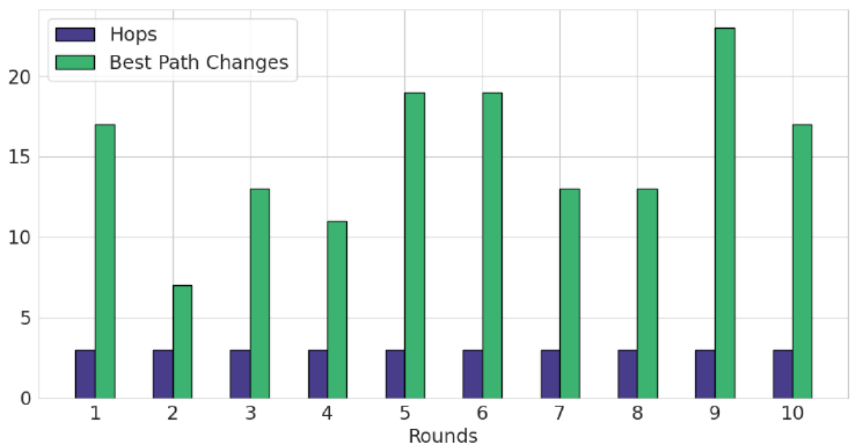
Figure 7. Number of Hops and Best Path Changes (BPC) pers round.